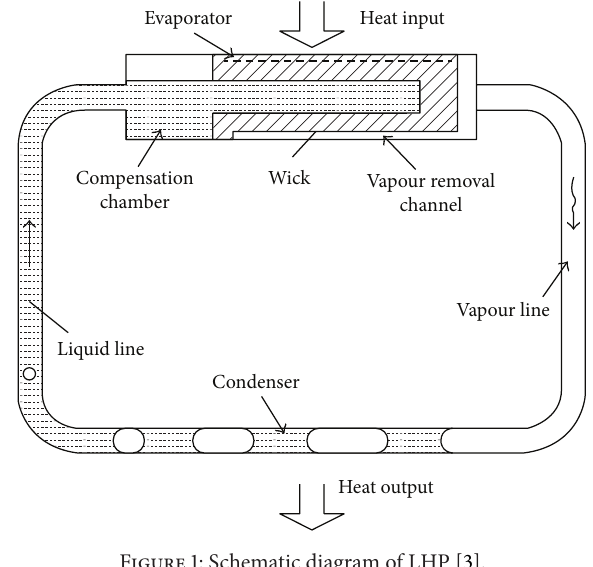
Figure 1: Schematic diagram of LHP